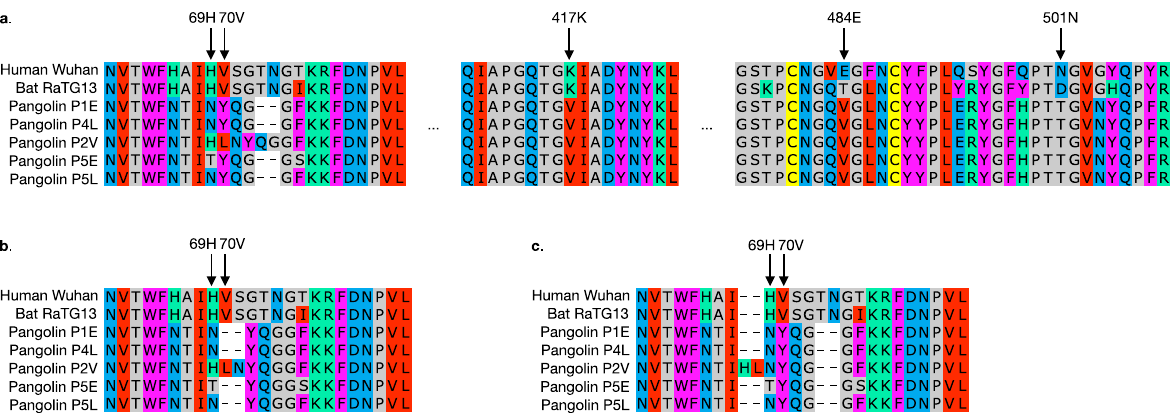
Fig. 2 MSA around residues 69, 70, 417, 484, and 501, visualized by Jalview 29 . a MSA used in reference 1 . b , c Alternative MSAs around residues 69 and 70.